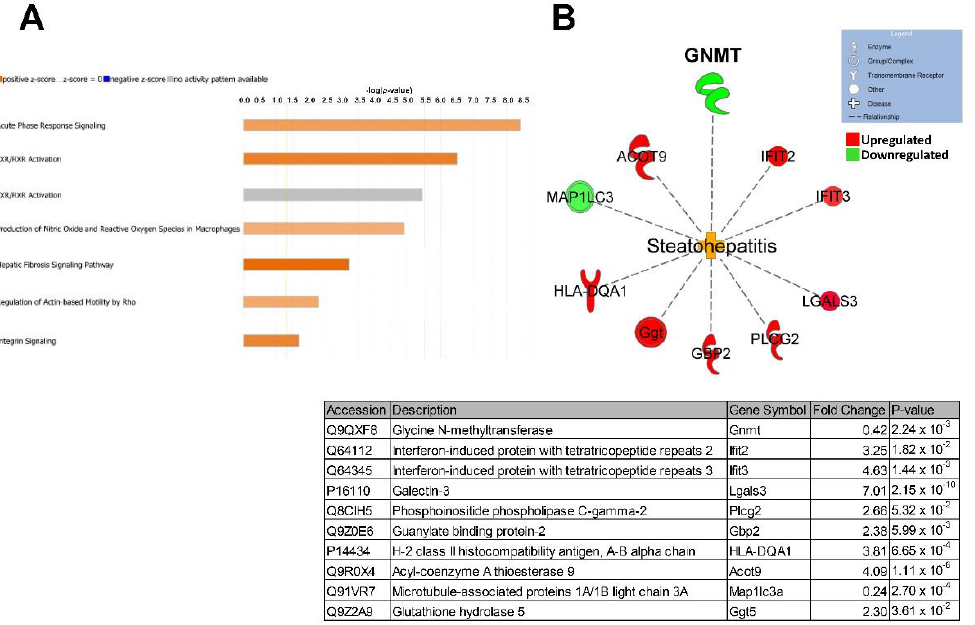
Figure 3. Proteomic characterization of NASH animal model shows human pathophysiology. ( A ) Heat map displaying differentially regulated proteins involved in apoptosis, lipid metabolism, fi- brosis, and inflammation. ( B ) Individual bar graphs for markers of NASH. Glycine N-methyltrans- ferase (GNMT), platelet glycoprotein 4 (CD36), acyl-coenzyme A thioesterase 9 (Acot9), collagen type 1 alpha 1 chain (COL1A1), actin alpha 2 (Acta2), decorin (Dcn), galectin-3 (Lgals3), interferon- induced protein with tetratricopeptide repeats 3 (Ifit3).